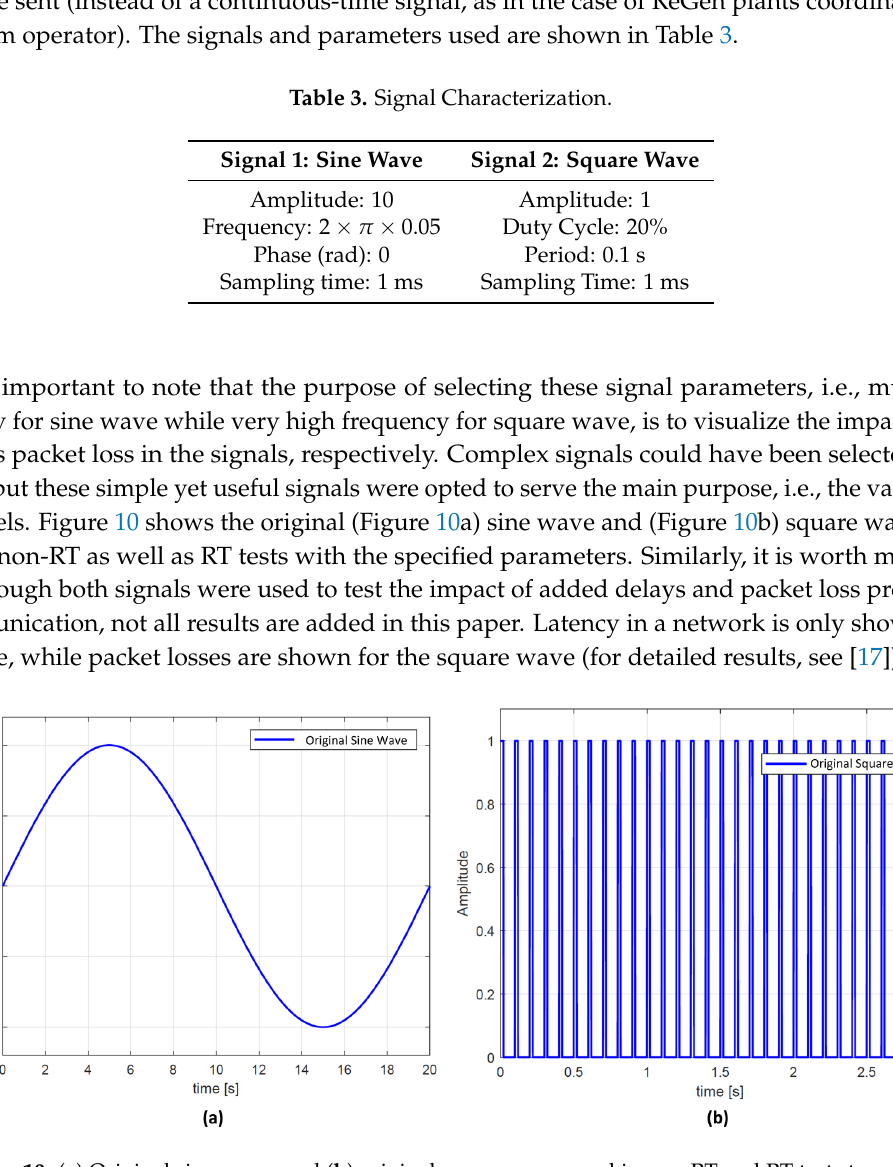
Figure 10. ( a ) Original sine wave; and ( b ) original square wave used in non-RT and RT tests to validate impact of delay on a